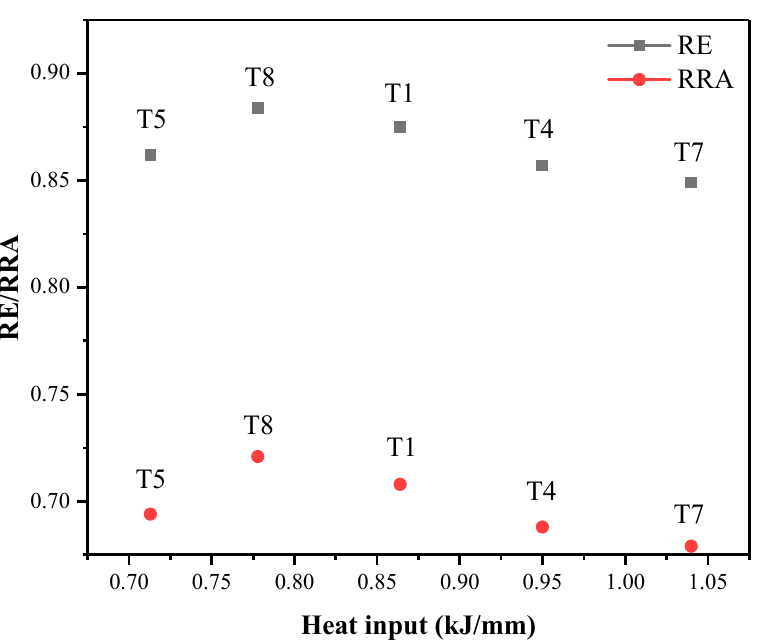
Figure 8. The RE/RRA plotted against the heat input.